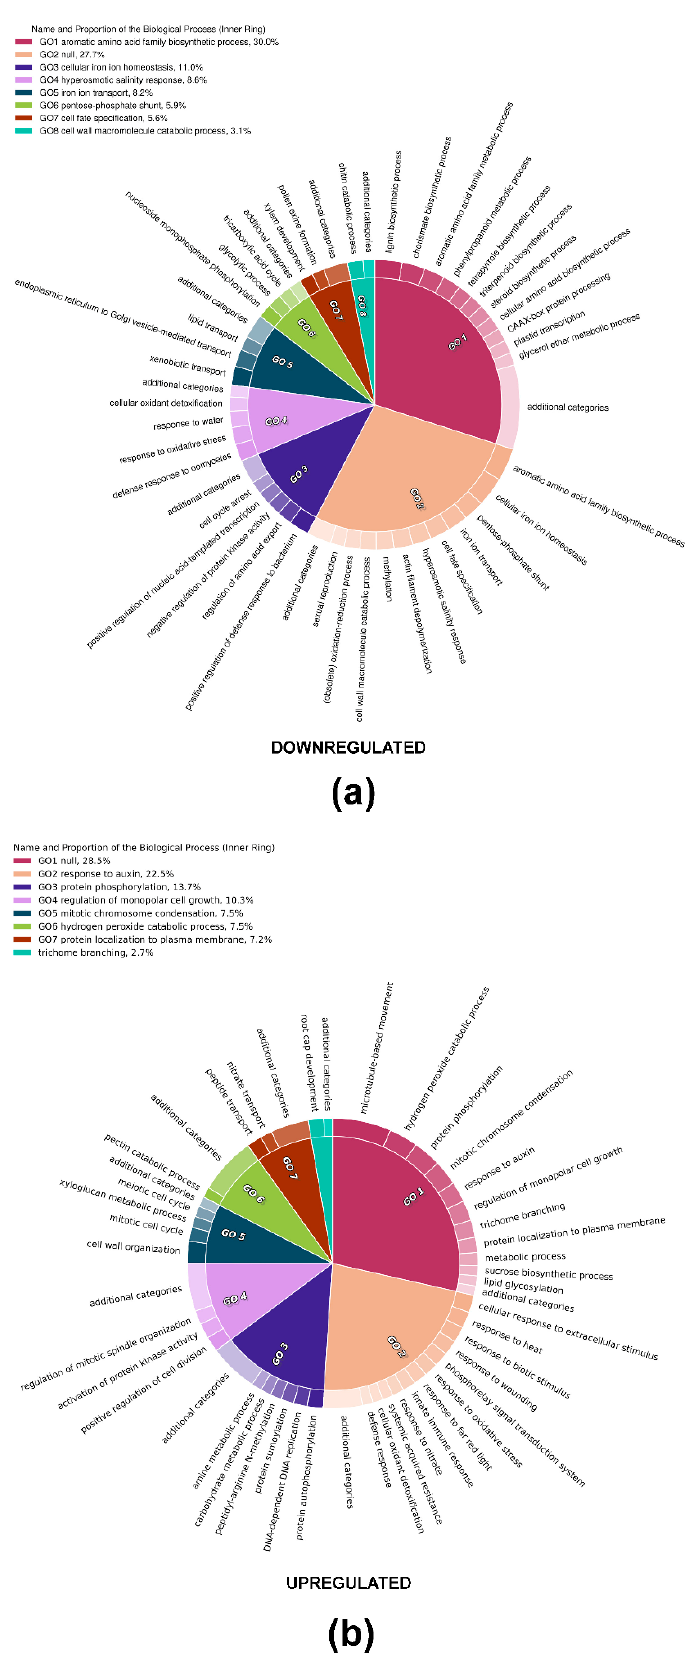
Figure 4. Gene Ontology Expression Analysis: Gene Ontology ( a ) downregulated and ( b ) upregulated terms referred to biological processes enriched among core-DEGs.